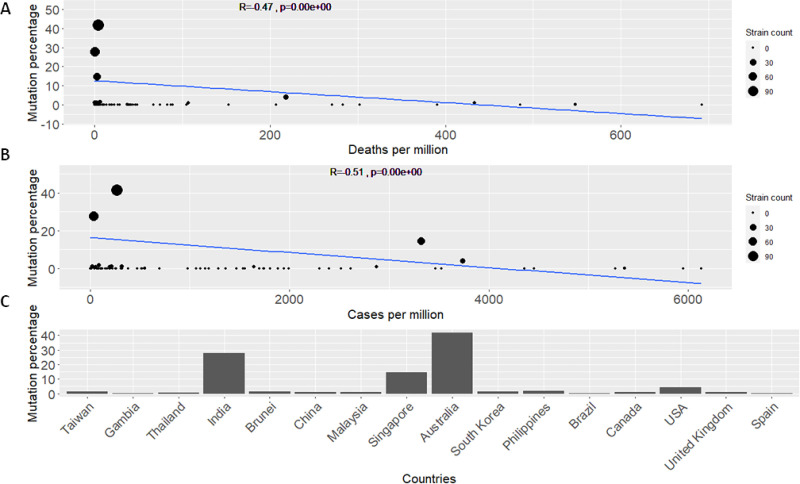
Analyses plots for N protein mutation at position 28311 (P13L).A. Regression model line showing the simplified fit for mutations percentage across countries and the deaths per million for each country. Pearson’s correlation is shown by the R value accompanied by the p-value of the correlation coefficient. B. Similar regression fit for mutations percentage across countries this time showing cases per million for each country. Pearson’s correlation is shown by the R value accompanied by the p-value of the correlation coefficient. C. Detailed histogram of the percentage occurrence of the mutation across different countries. These values make up the “percent” predictor variable utilized in our model (see Materials and Methods). Countries are sorted with increasing deaths per million.